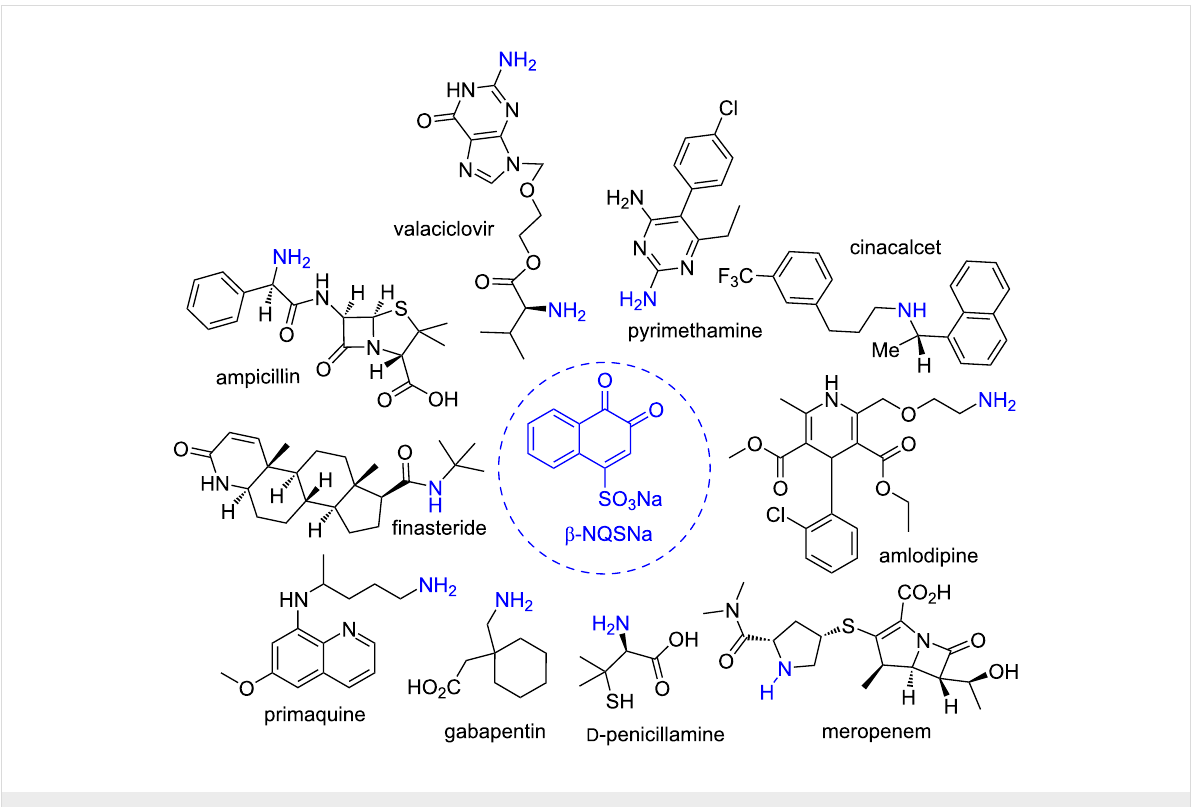
Figure 3: Drugs detected using β